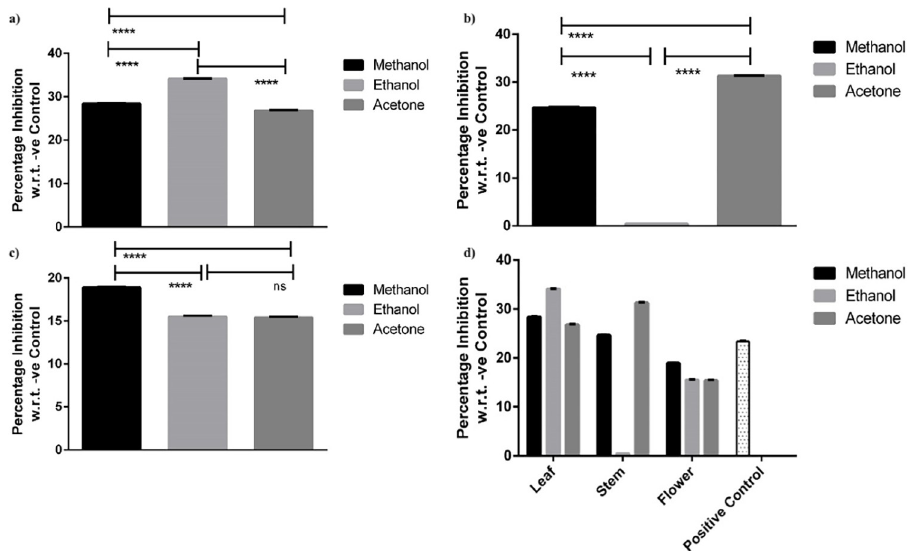
Fig 4. Comparison of Anti-diabetic activity of Artemisia absinthium of methanolic, ethanolic & acetone extracts of selected plant parts i.e. Leaf (a), Stem (b) & Flower (c). Statistical relationship of all plant parts (d) was determined by Tukey’s multiple comparison test. Data was analyzed by two-way analysis of variance (ANOVA) (P < 0.001). Bars represents the ± SEM and comparison with Positive control. * = Significant, ns = Non-Significant.